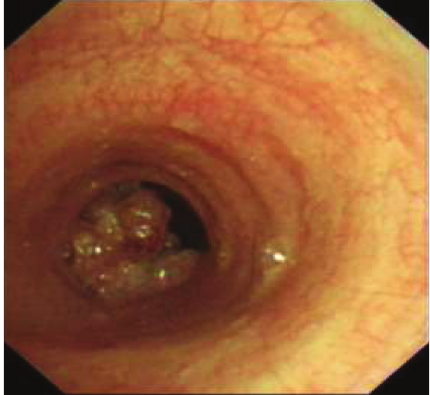
Figure 3: Bronchoscopic view of the lesion, causing 80% obstruc- tion at the tracheal lumen.